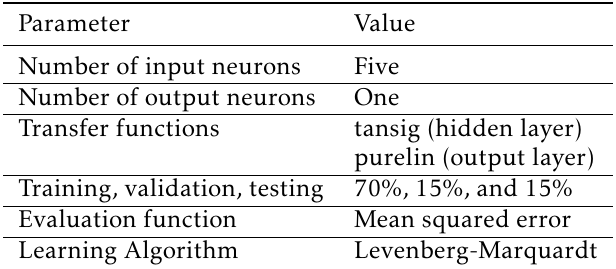
Figure 2. General Structure of the NARX Neural Network. u is the activation function, w is the weight, and b is the bias factor.